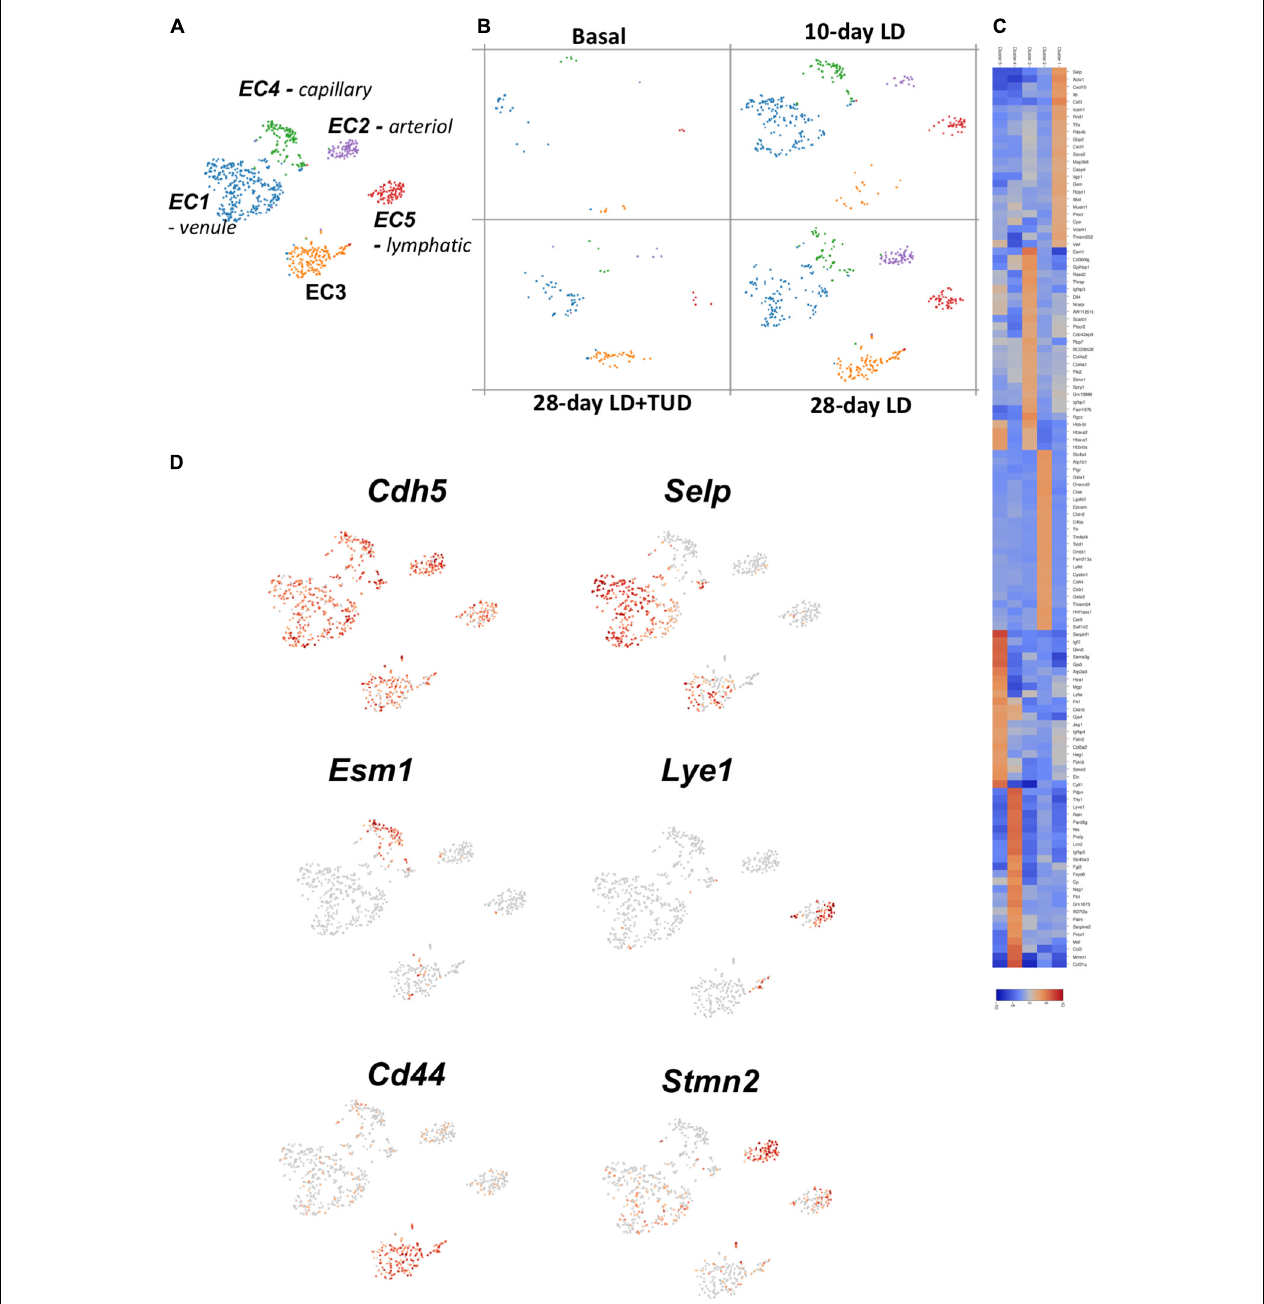
FIGURE 5 | Sub-clustering analysis of the transcriptomes of endothelial cells (ECs) by k-means analysis. (A) t-SNE plot identification of subclusters of the EC (cluster 14) which were classified into five types. (B) Dynamic changes of ECs during gallstone formation. Cells in all clusters increased rapidly as early as day 10 after LD feeding, especially cluster 1, and constantly increased at day 28 and were mitigated under TUCDA treatment. (C) The heatmap indicated enriched expression of specific marker gene expressions of each type of ECs according to their transcriptome pattern. (D) t-SNE plot highlighting the sub-clusters of ECs according to representative markers, such as Cdh5 (pan-marker), Selp (venule), Esm1 (capillary), Lye1 (lymphatic), Cd44 (EC3), and Stmn2